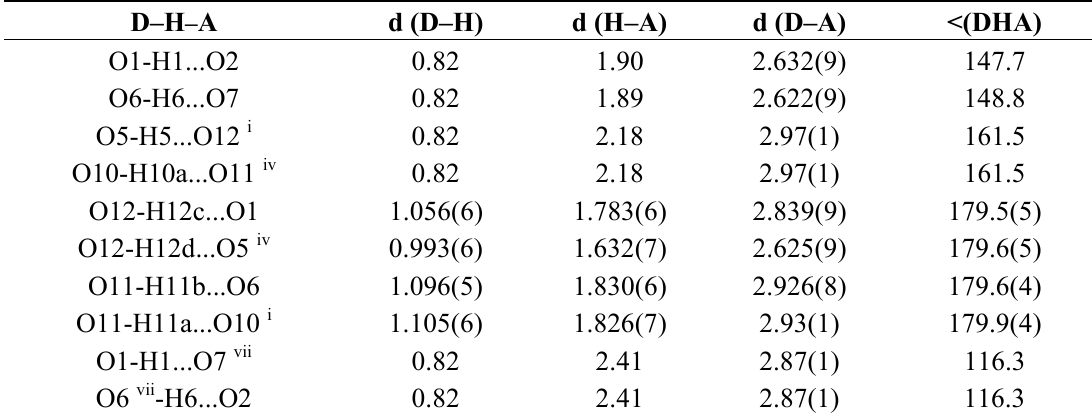
Table 3. Hydrogen bond angles (°) and distances (Å). The characters “D” and “A” refer to hydrogen bond donor and acceptor.